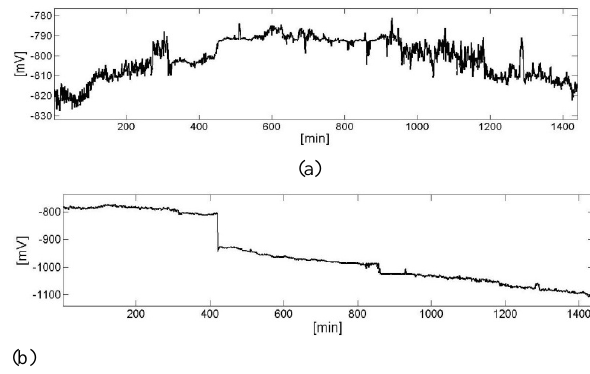
Figure 3. Raw Geoelectric field data: (a) E-W and (b) N-S polarity prior to 6.6R EQ on 20 Fig. 3. Raw geoelectric field data: (a) E–W and (b) N–S polarity prior to 6.6R EQ on 6 January 2008.